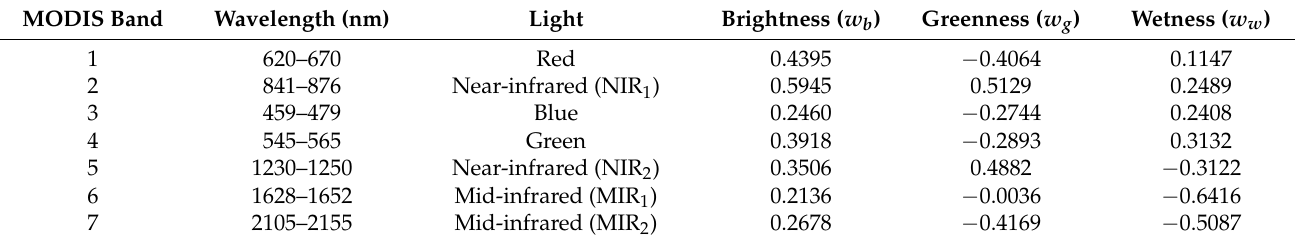
Table A1. MODIS instrument specifications and tasseled cap coefficients from